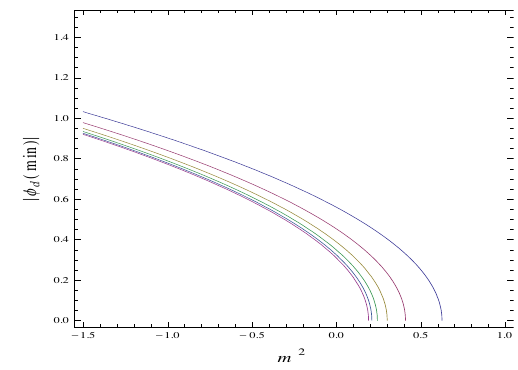
(a) Effective potentials corresponding to the two roots of the saddle point equation for λ = 1 , m 2 = − 0 . 8 , β = 1 and n = 10 . Figure 4. Bounded/unbounded effective potentials and M 2 = 0 plots for AdS 3 with negative renormalized volume.